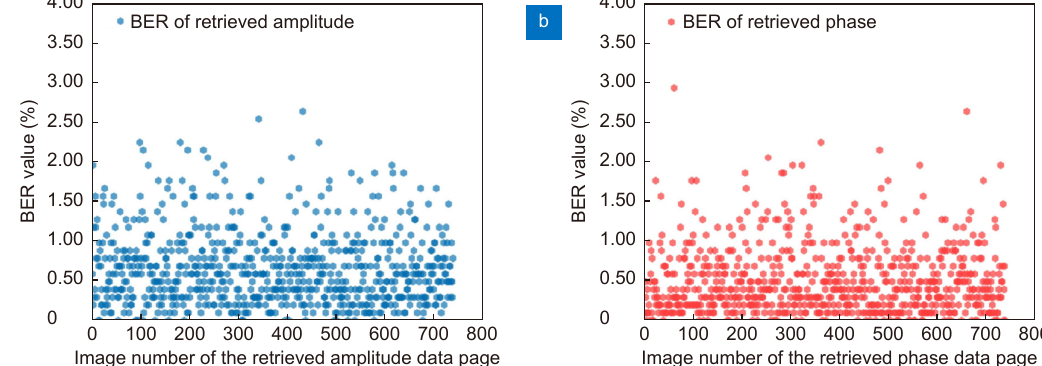
Fig. 14 | BER distribution of all the complex-amplitude data pages in the test dataset. ( a ) Amplitude BER. ( b ) Phase